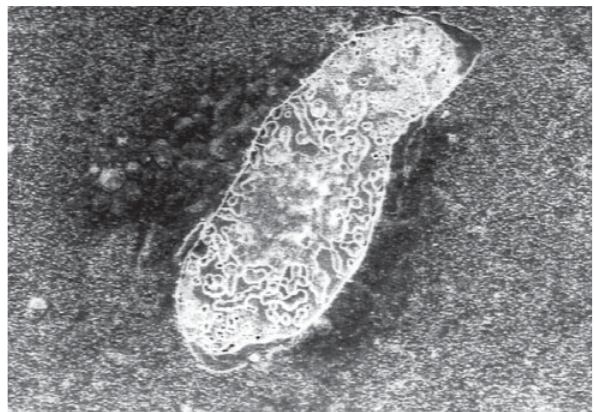
Figure 5. Observation of a spalled zone by SEM on the 439 steel oxidized at 950 °C in Ar-H